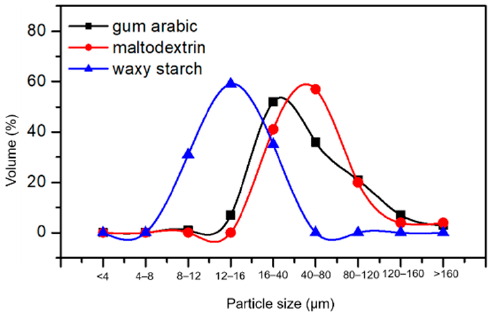
Figure 2. Particle size distribution of freeze-dried pomegranate powders produced with different carriers.